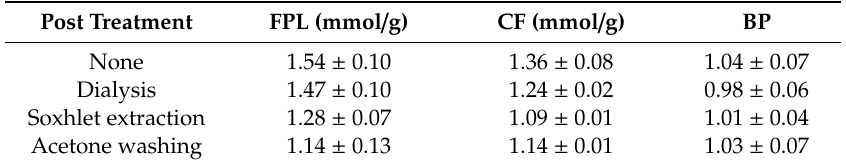
Table 1. Degree of oxidation for CNCs (using 3 moles of NaOCl oxidant per mole of cellulose) before and after